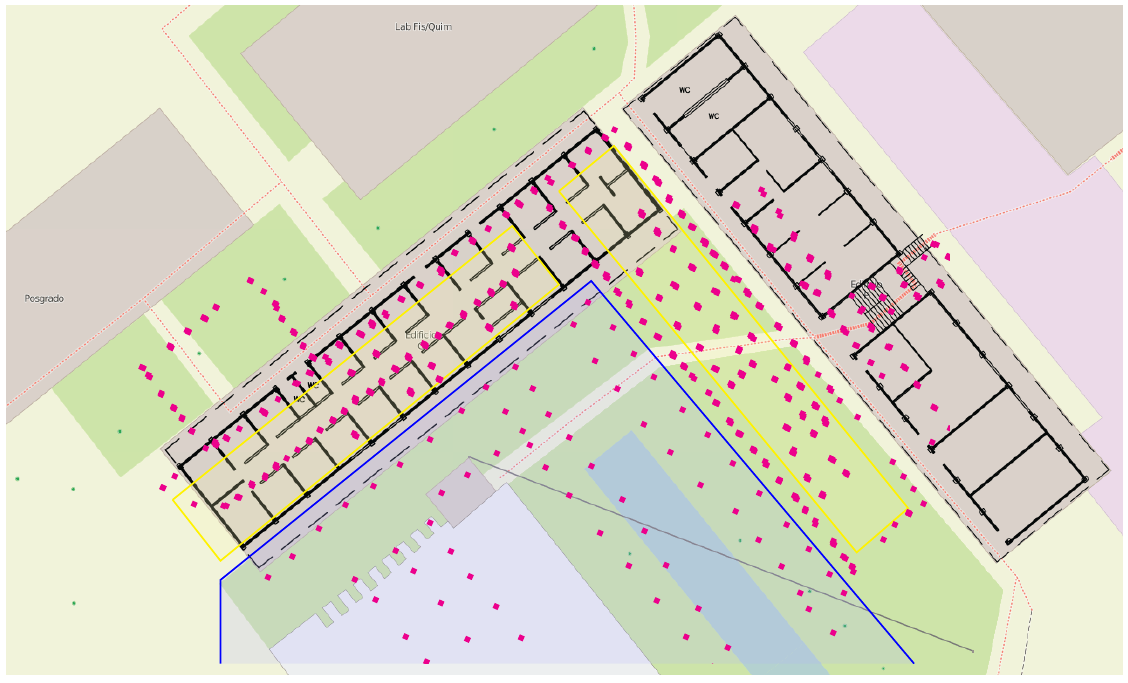
Figure 1. Test area and fingerprint positions (magenta dots) of one access point. Reference points within the yellow shaded area belong to the Indoor dataset; reference points lying in the blue shaded area form the Outdoor-2 dataset; and all other fingerprints belong to Outdoor-1. c OpenStreetMap contributors (cid:13)